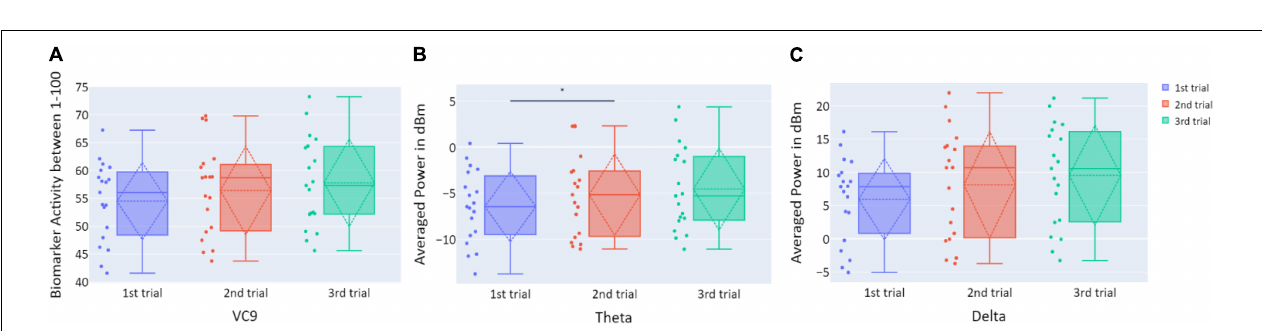
FIGURE 9 | The means of accuracy (in percentage), economy of movement (in percentage), and time to exceed the task (in seconds) obtained in the three trials of Experiment 3, as a function of task repetitions: first trial (blue), second trial (red), and third trial (green), for participants who underwent Experiment 3 ( n = 19). Error bars represent standard errors. ∗ p < 0.05, ∗∗ p < 0.01, and ∗∗∗ p < 0.001.